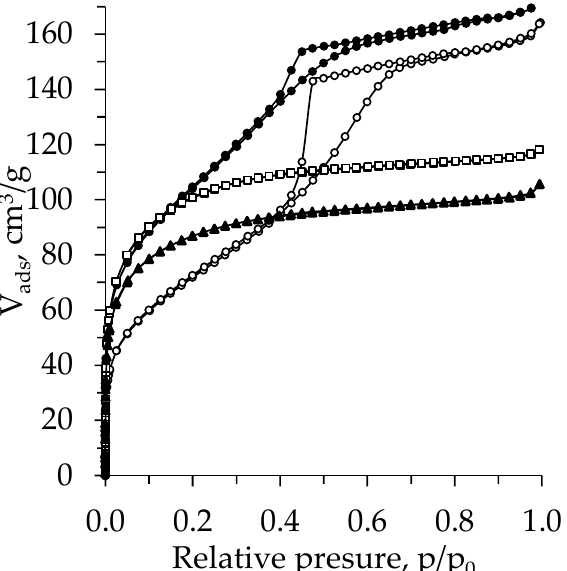
Figure 8. Isotherms for subcritical dried TiO 2 aerogel synthesized using the precursor TIP and ad- ditional nH exchange (unaged ( ▲ –without exchange, –nH) and aged ( –without exchange, – nH)).